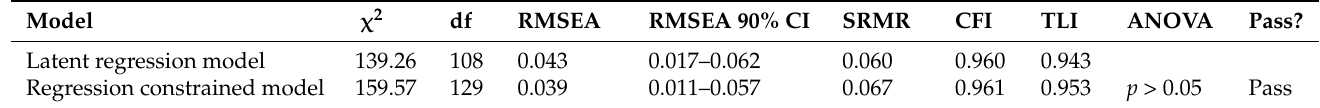
Table 4. Multigroup analysis.